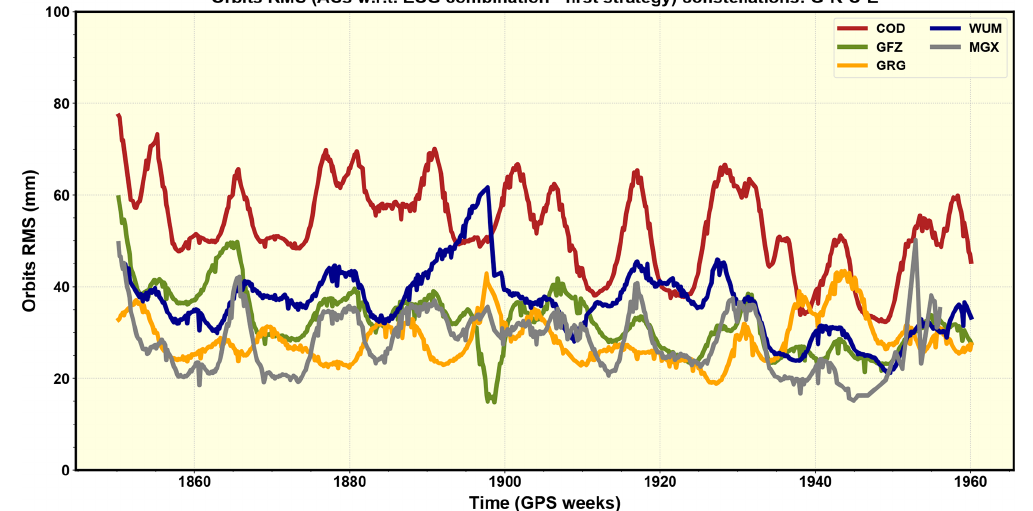
Figure 4. RMS values with respect to the individual ACs’ MGEX submission orbits using all constellations and the ECG combination results computed by the ERP strategy